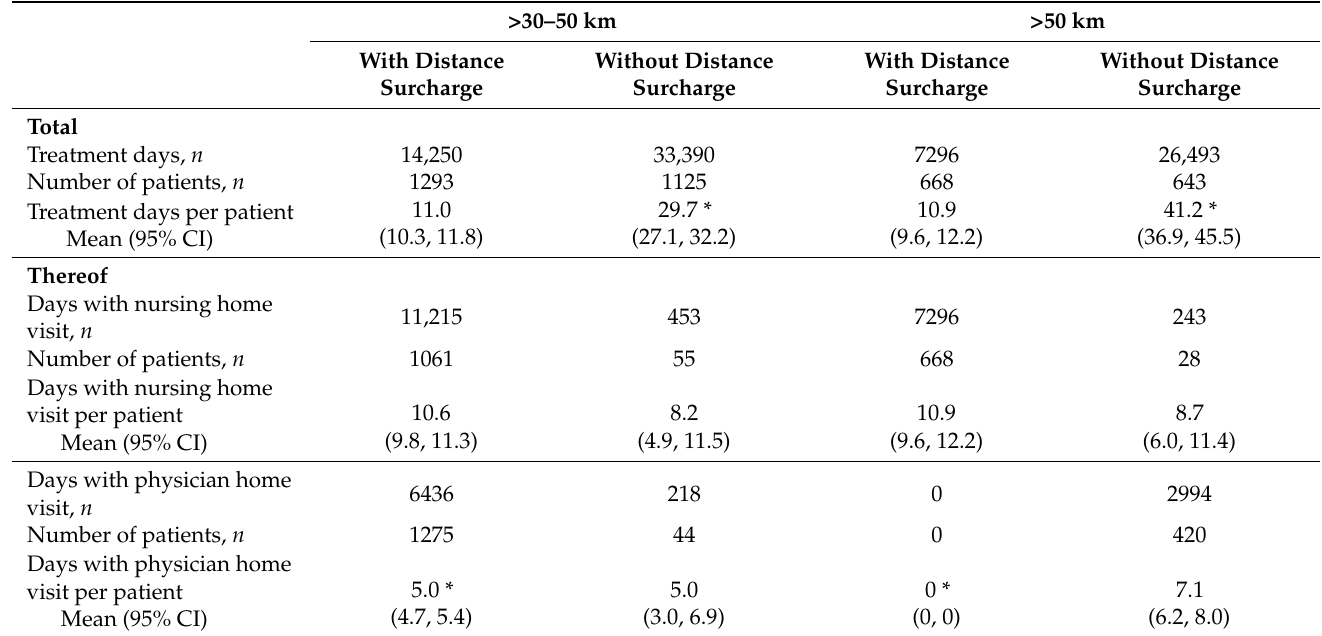
Table 3. Services with and without distance surcharge for patients in a distance of >30 km from the SAPV team’s site (2014–2017). >30–50 km >50 km With